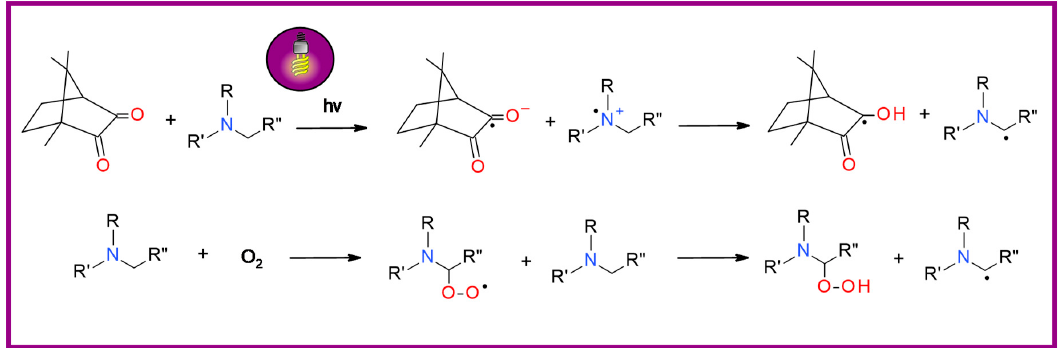
Figure 8. The initiation mechanism using bimolecular photoinitiator system containing camphorquinone and aromatic amine; mechanism of reaction amine with oxygen.